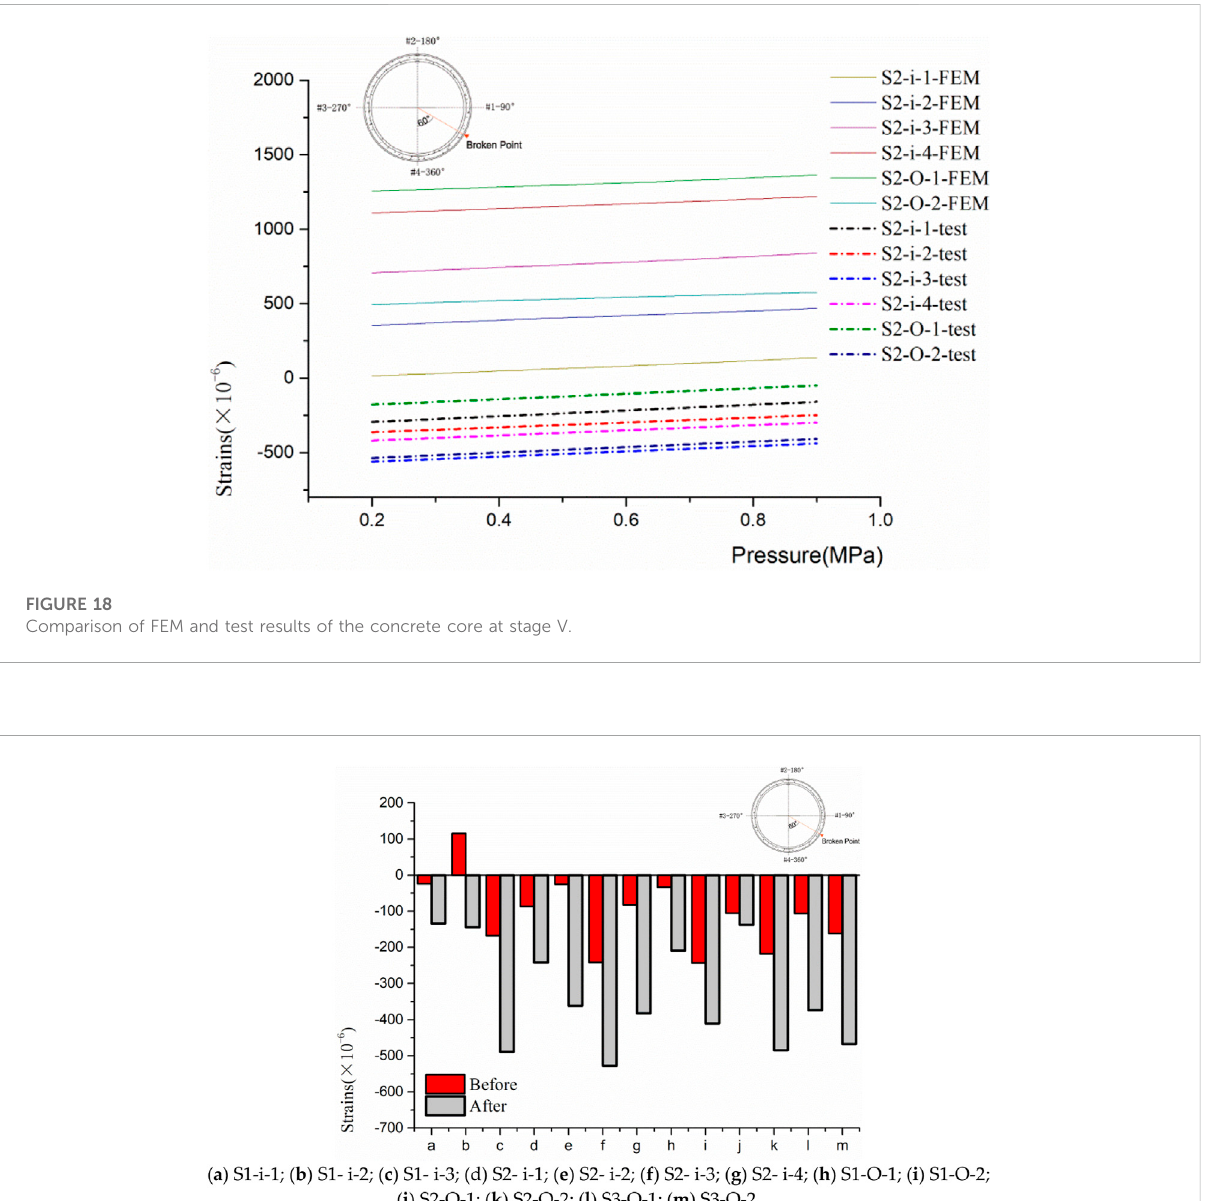
FIGURE 19 Strain of the concrete core at the working pressure before and after